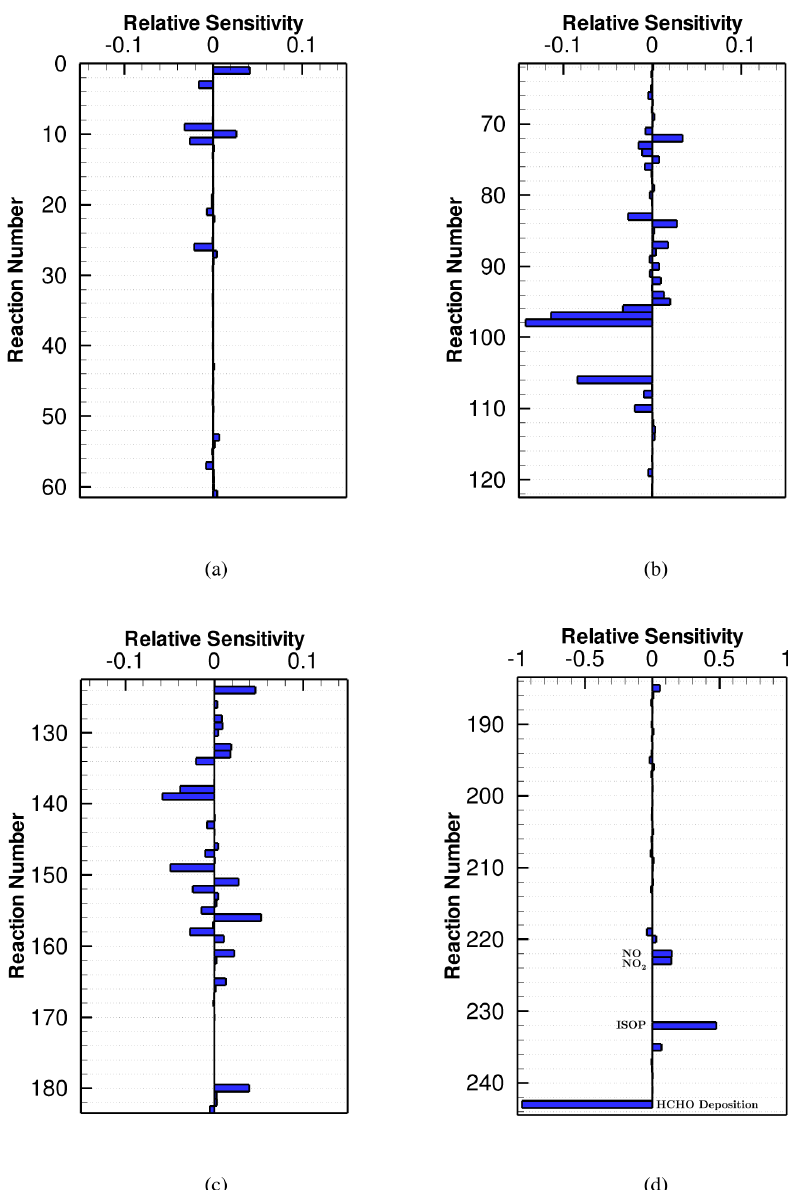
Figure 4. Averaged HCHO sensitivity to the CB6r3 mechanism over the seventh day, when the surface emission is weak. Note that the horizontal scales of the sub-figures are different. All the values of the sensitivities shown in this figure can be found in Table